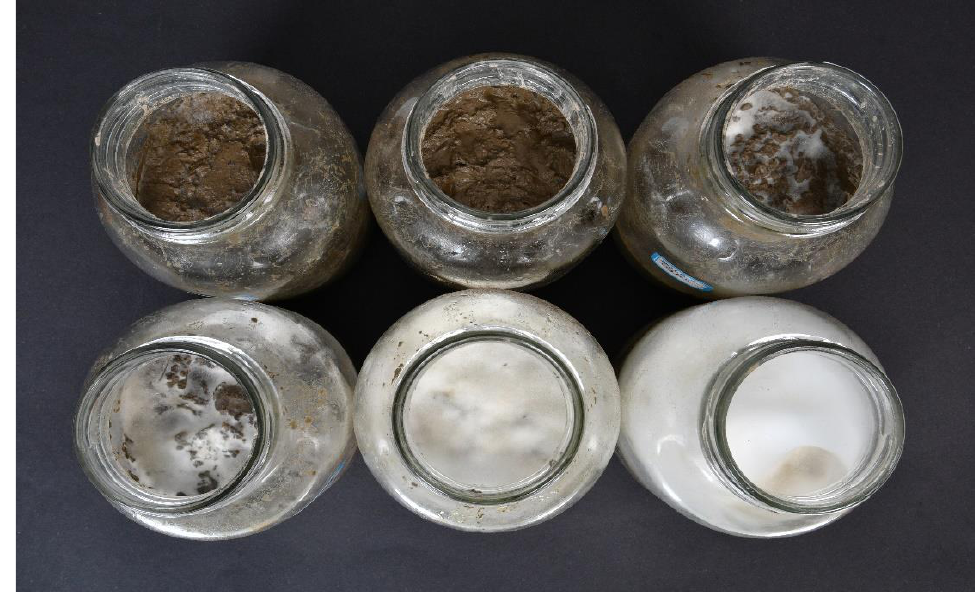
Figure 2. Fertilizer and vegetable oil (SIFVO) treatments on day 4 in the mesocosm incubation (MI) experiment. The bottles from upper left to the lower right were treated with the same fertilizers and 0, 2, 5, 10, 20, and 40 g/kg of vegetable oil.